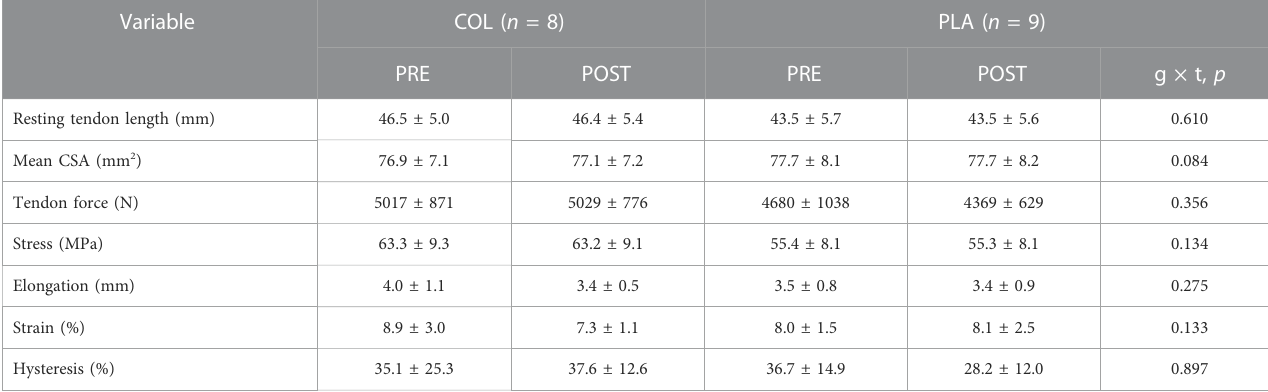
TABLE 5 Patellar tendon properties in PLA and COL before (PRE) and after (POST) training. Data are mean ± SD.